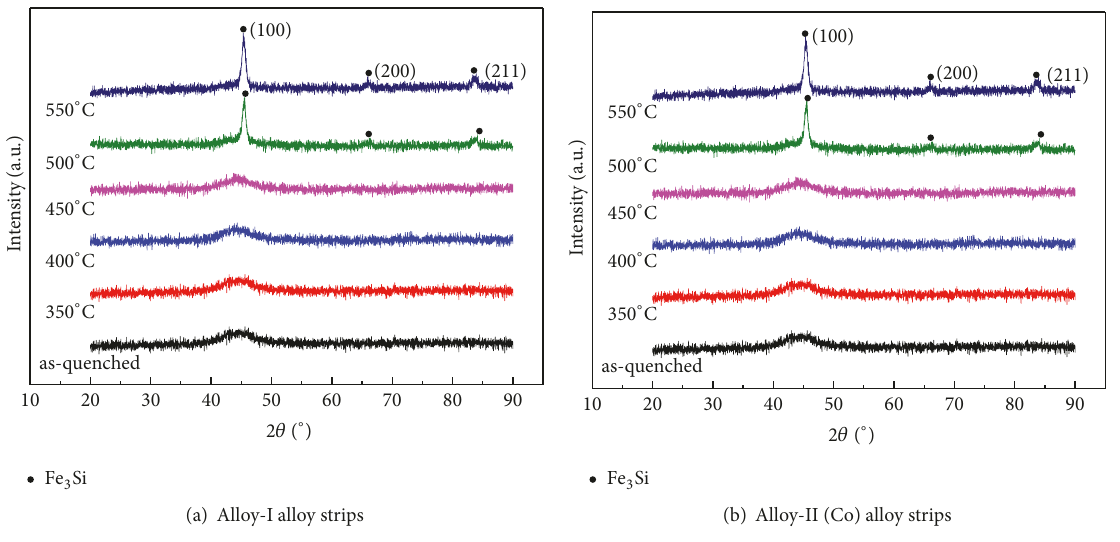
Figure 4: XRD patterns of as-quenched and annealing alloy